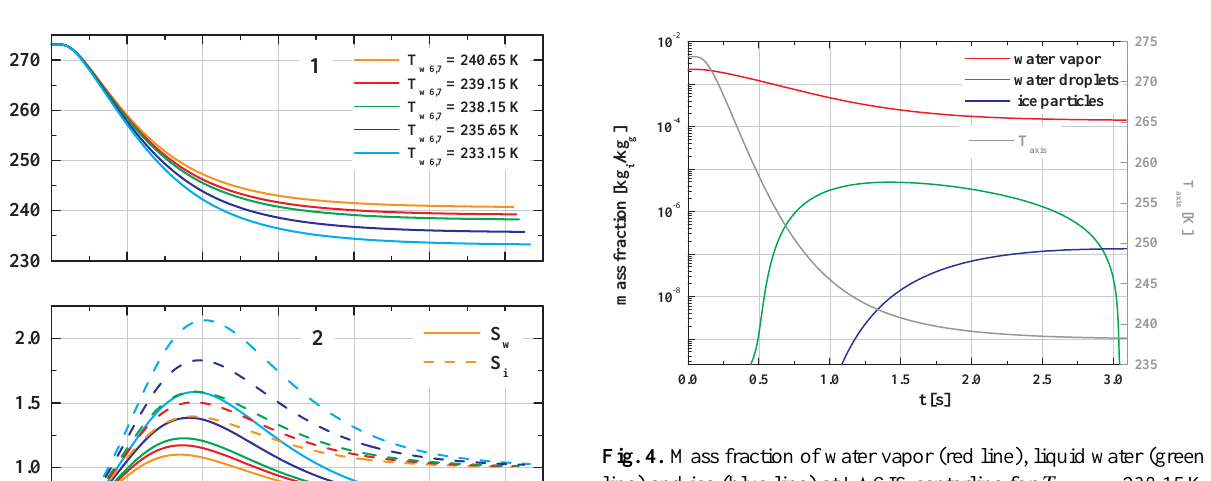
Fig. 4. Mass fraction of water vapor (red line), liquid water (green Fig. 14. Mass fraction of water vapor (red line), liquid water (green line) and ice (blue line) at LACIS centerline for T w6 , 7 = 238 . 15K line) and ice (blue line) at LACIS centerline for T w 6 , 7 = 238 . 15 K (left ordinate). The axial temperature T axis is presented by the gray (left ordinate). The axial temperature T axis is presented by the gray solid line (right ordinate). solid line (right